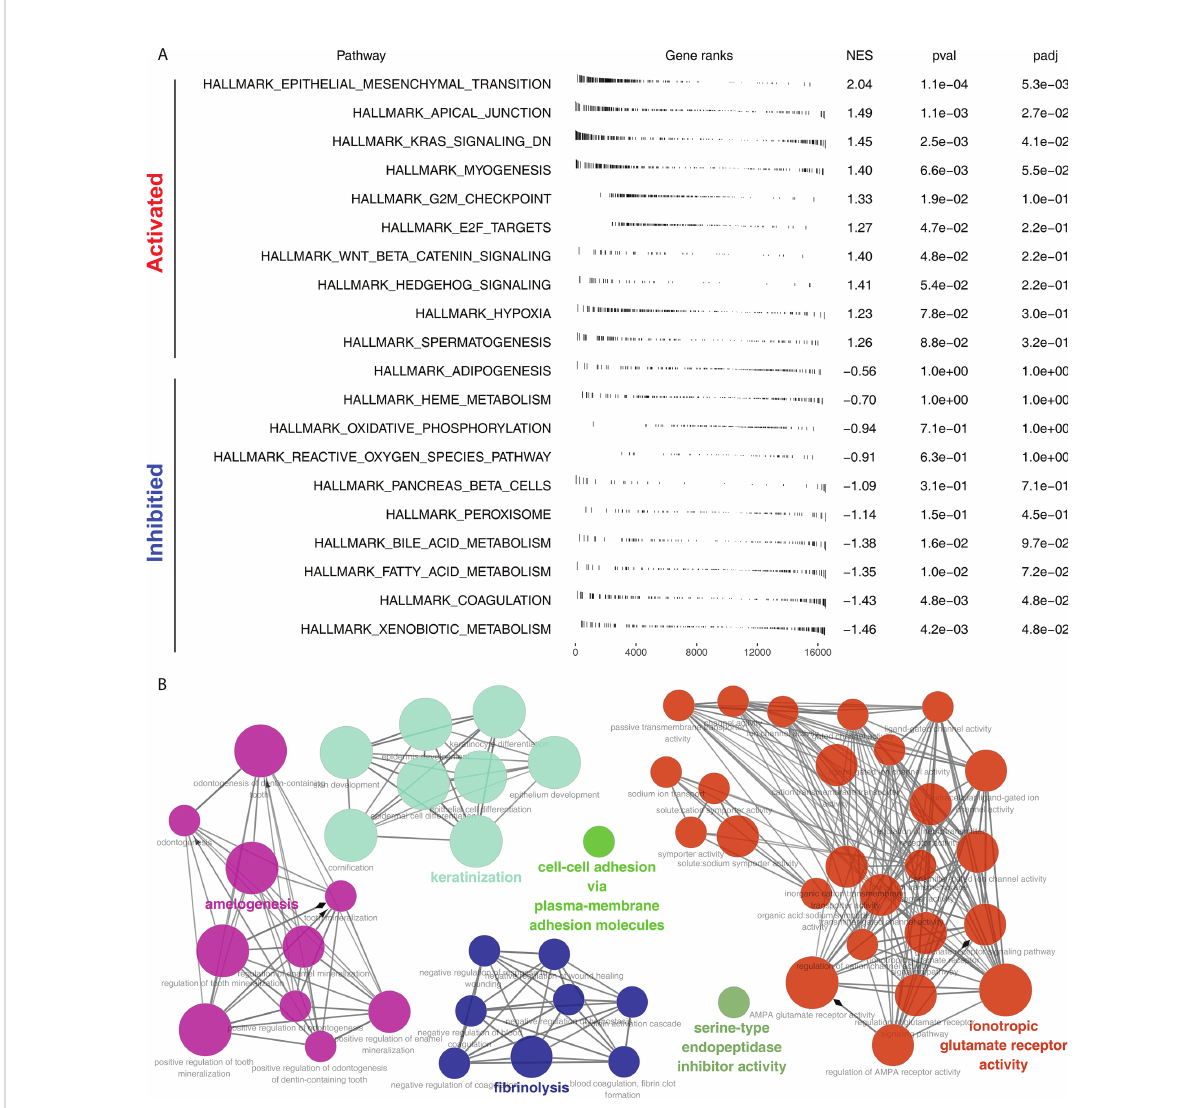
FIGURE 5 Biological enrichment analysis. (A) GSEA analysis of Cluster2 based on the Hallmark gene set; (B) ClueGO analysis of input